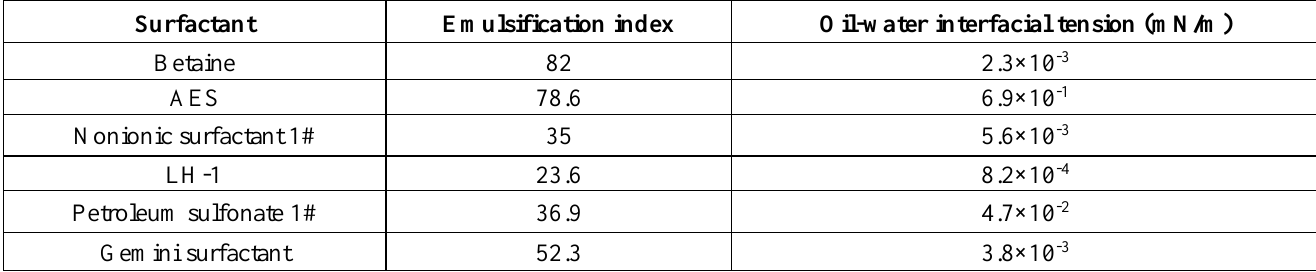
Table 2—Results of the oil displacement test of betaine surfactant with different concentrations. Porosity